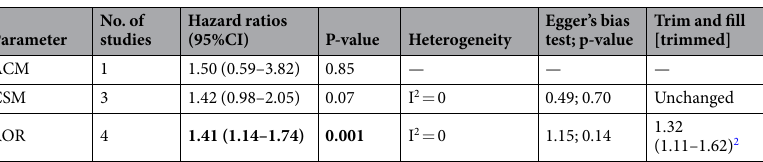
Table 2. Pooled risk ratio estimates for adjusted hazard ratios for overall and disease-free survival by presence or absence of extranodal extension. Abbreviations: ENE: extranodal extension; CI: confidence interval; ACM: all-cause mortality; CSM: cancer-specific mortality; ROR: risk of recurrence. Bold values are significant results with p-values <